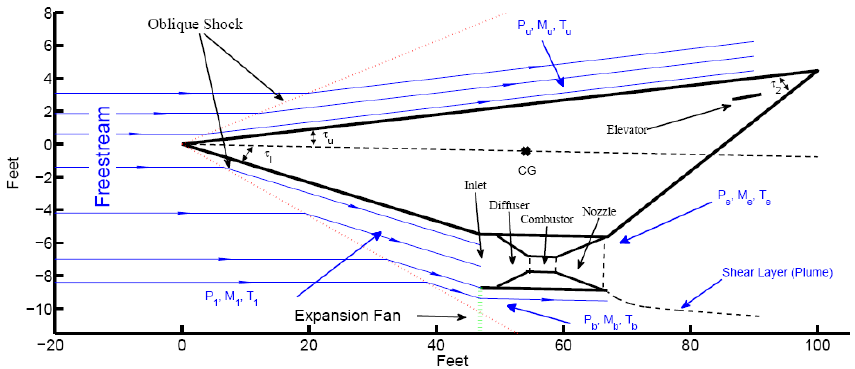
Figure 1. Geometry of HFV model.